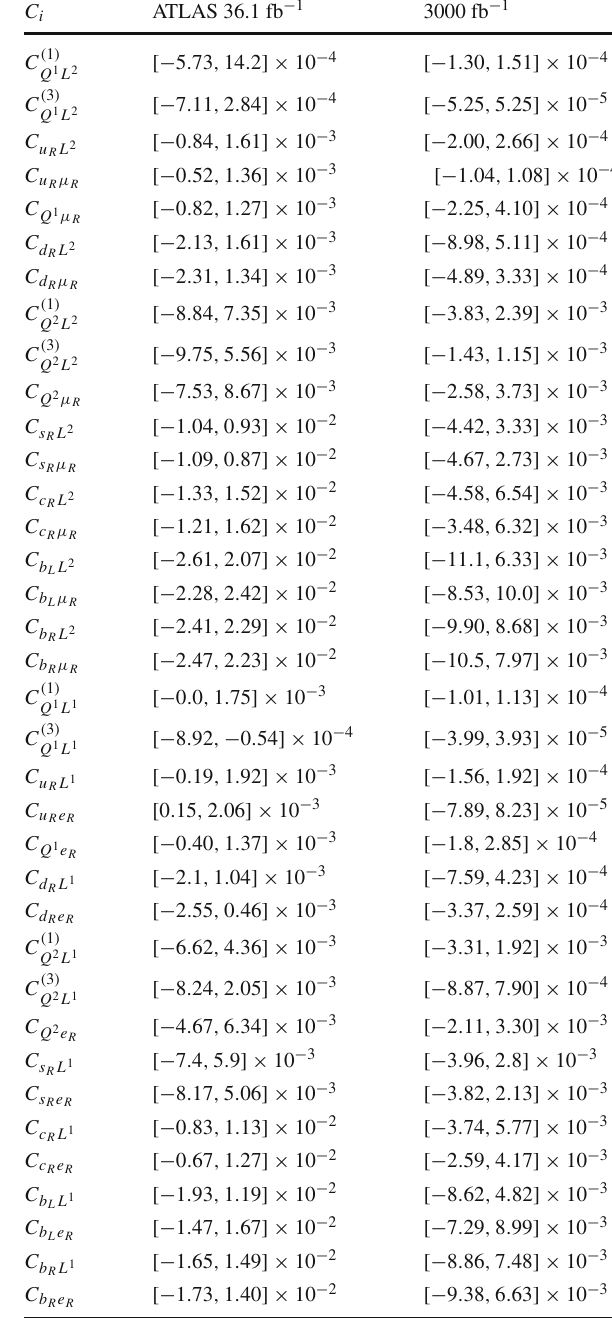
Table 1 One-parameter 2 σ limits from pp → μ + μ − , e + e